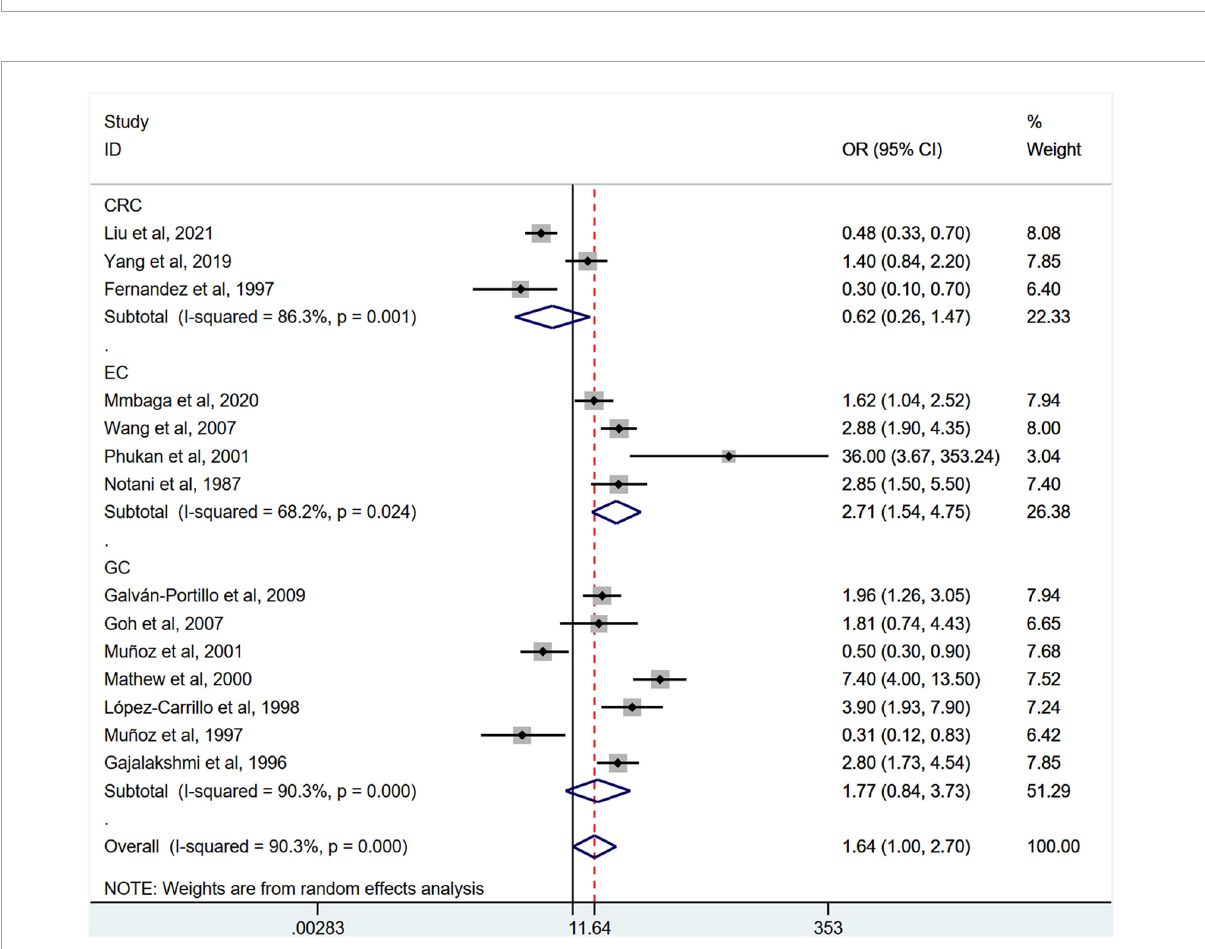
FIGURE4 Subgroup analysis showing associations between chili pepper consumption and the risk of GI cancers based on the cancer type. GC, gastric cancer; EC, esophageal cancer; CRC, colorectal cancer; OR, odds ratio; CI, confidence